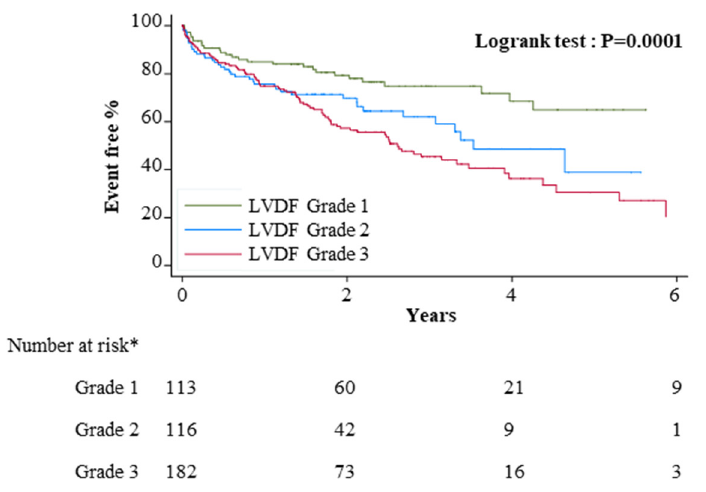
Figure 4. Survival according to the diastolic function grade . * 10 patients excluded patients be- cause of missing follow-up data. Event: death, heart transplant or circulatory assist device LVDF: left ventricular diastolic function